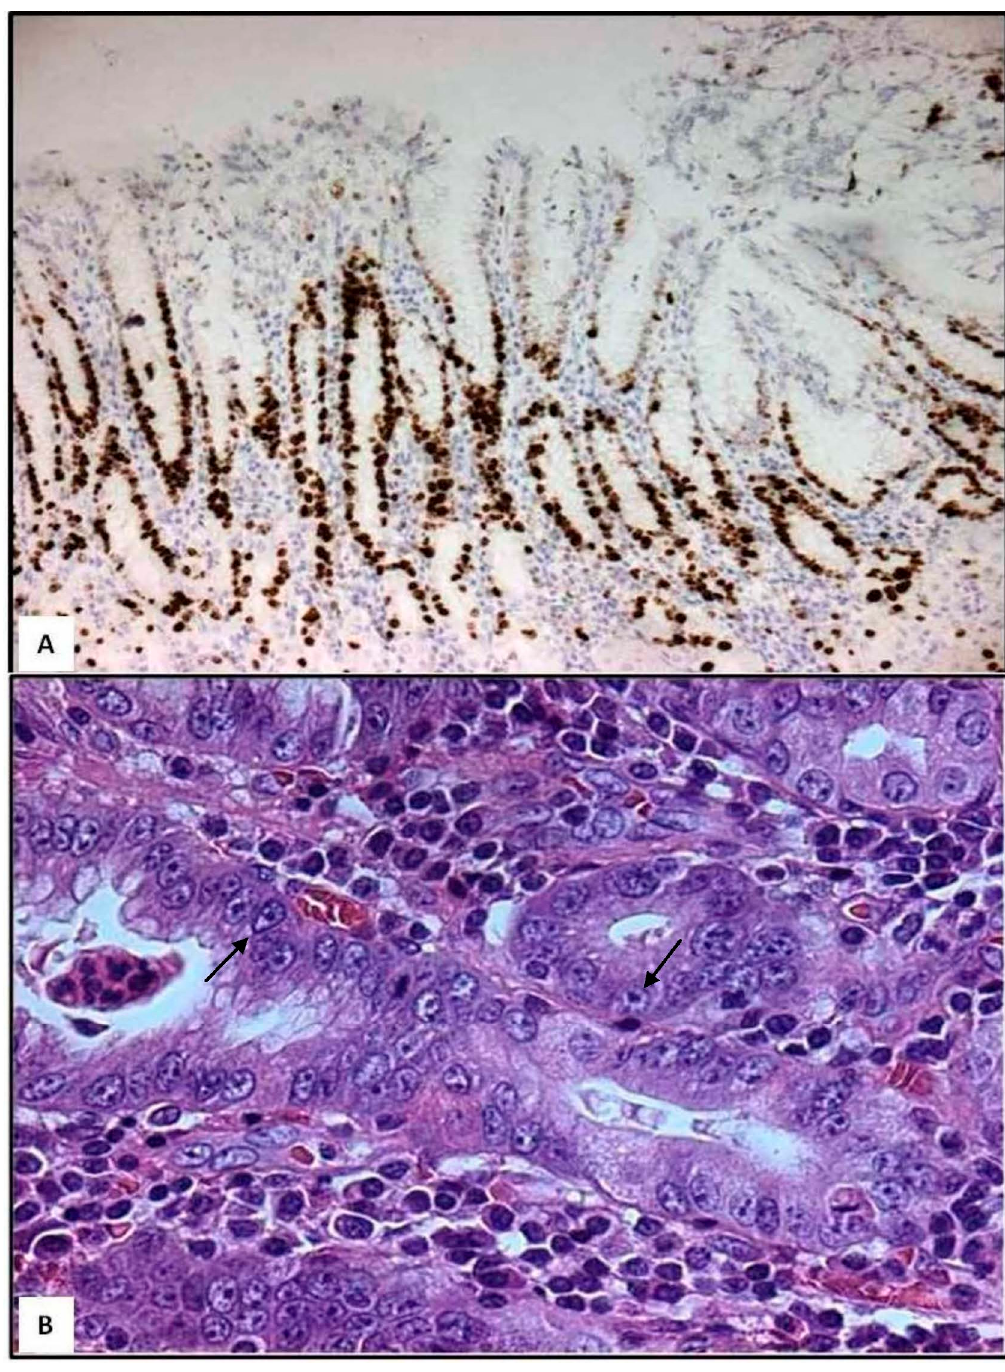
Figure 1. Gastric bioptic specimens—Ki-67-immunostained cycling epithelial cells in the deep foveolar zone and in the isthmus/neck region; few Ki-67-positive cells are present in deep glandular zone ( A , immunoperoxidase, Mayer’s haemalum counterstain, 160×). Epithelial cells of the proliferative zone exhibit enlarged nuclei containing prominent nucleoli (arrows) and cytoplasmic mucin loss ( B , haematoxylin and eosin, 400×). (Unpublished personal data).